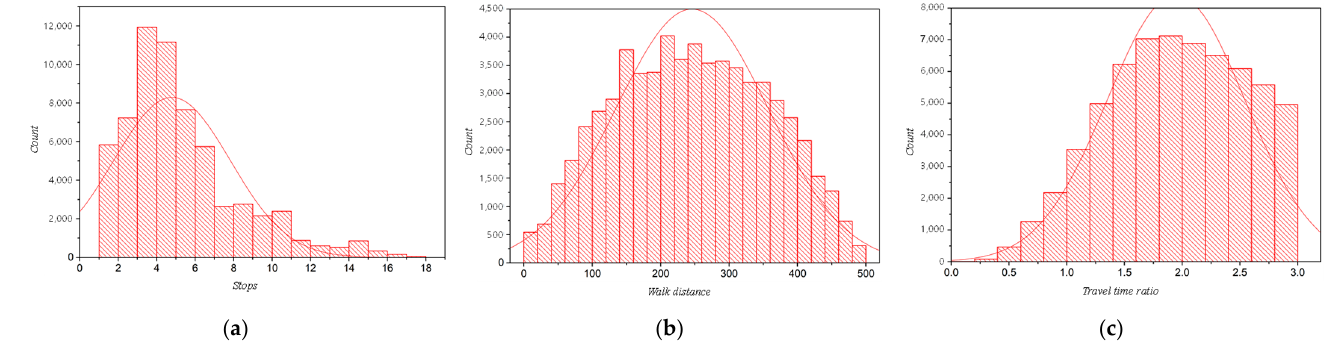
Figure 10. Response of shuttle routes to residents’ demands. ( a ) The number of stops taken; ( b ) walking distance; ( c ) ratio of travel time.